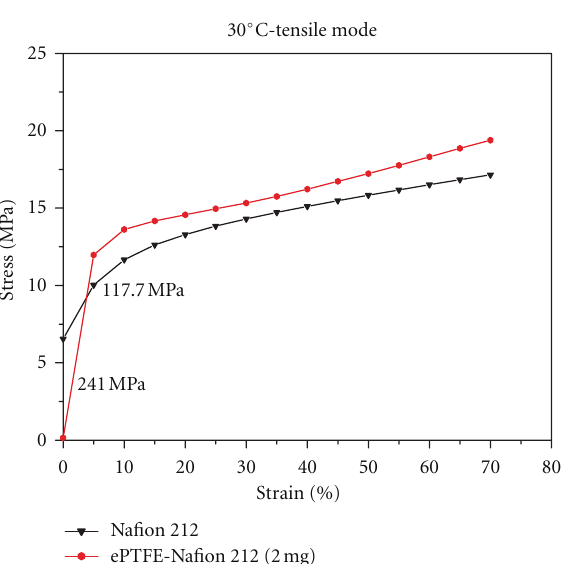
Figure 3: TGA curves for the substrate and the composite membrane. Figure 4: Stress-strain curves for the composite membrane and Nafion 212 membrane.